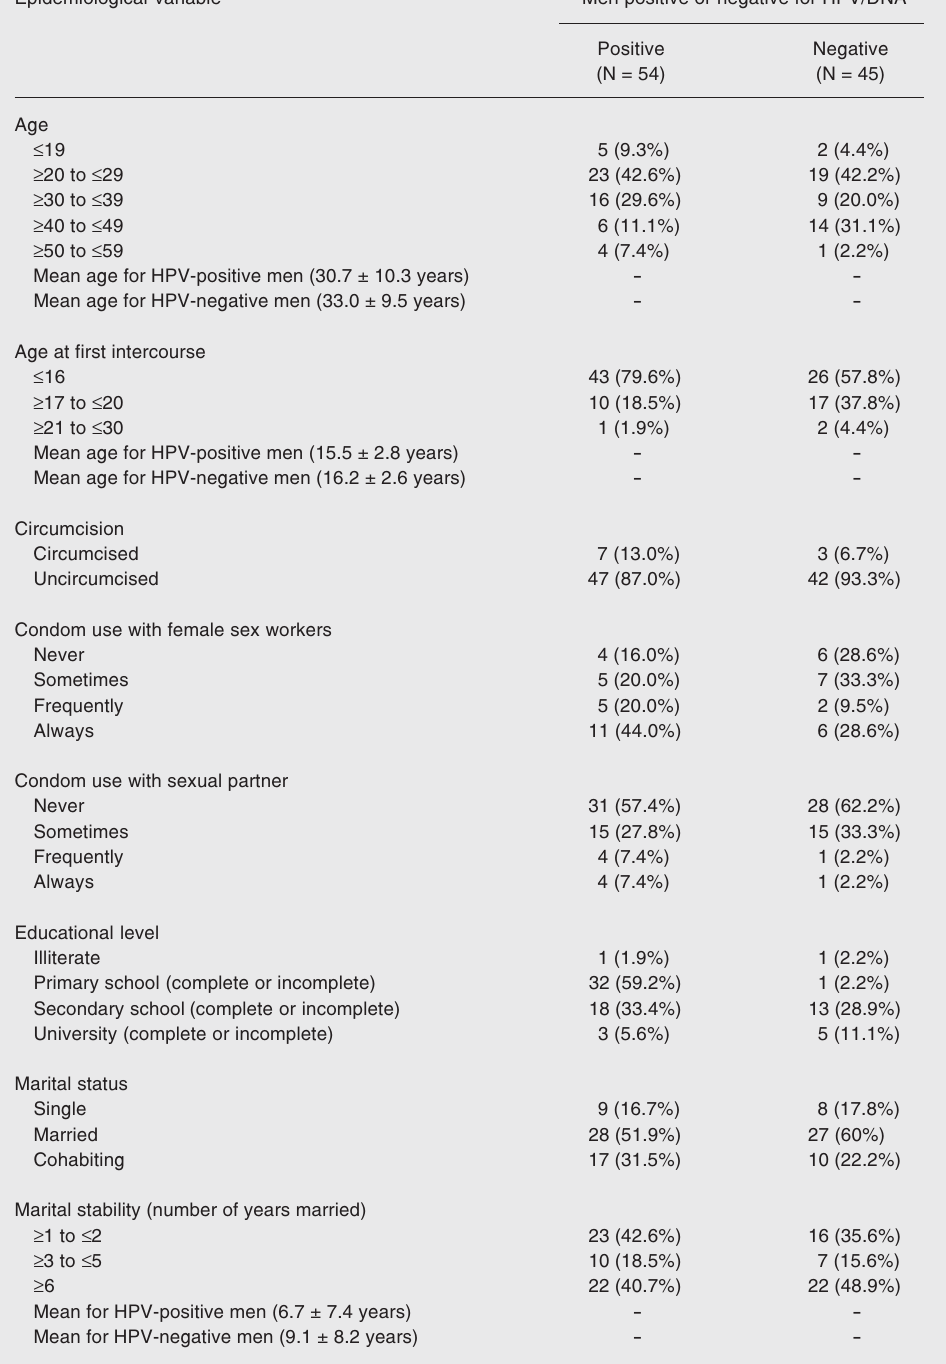
Table 3. Epidemiological variables investigated in the present study. Epidemiological variable Men positive or negative for